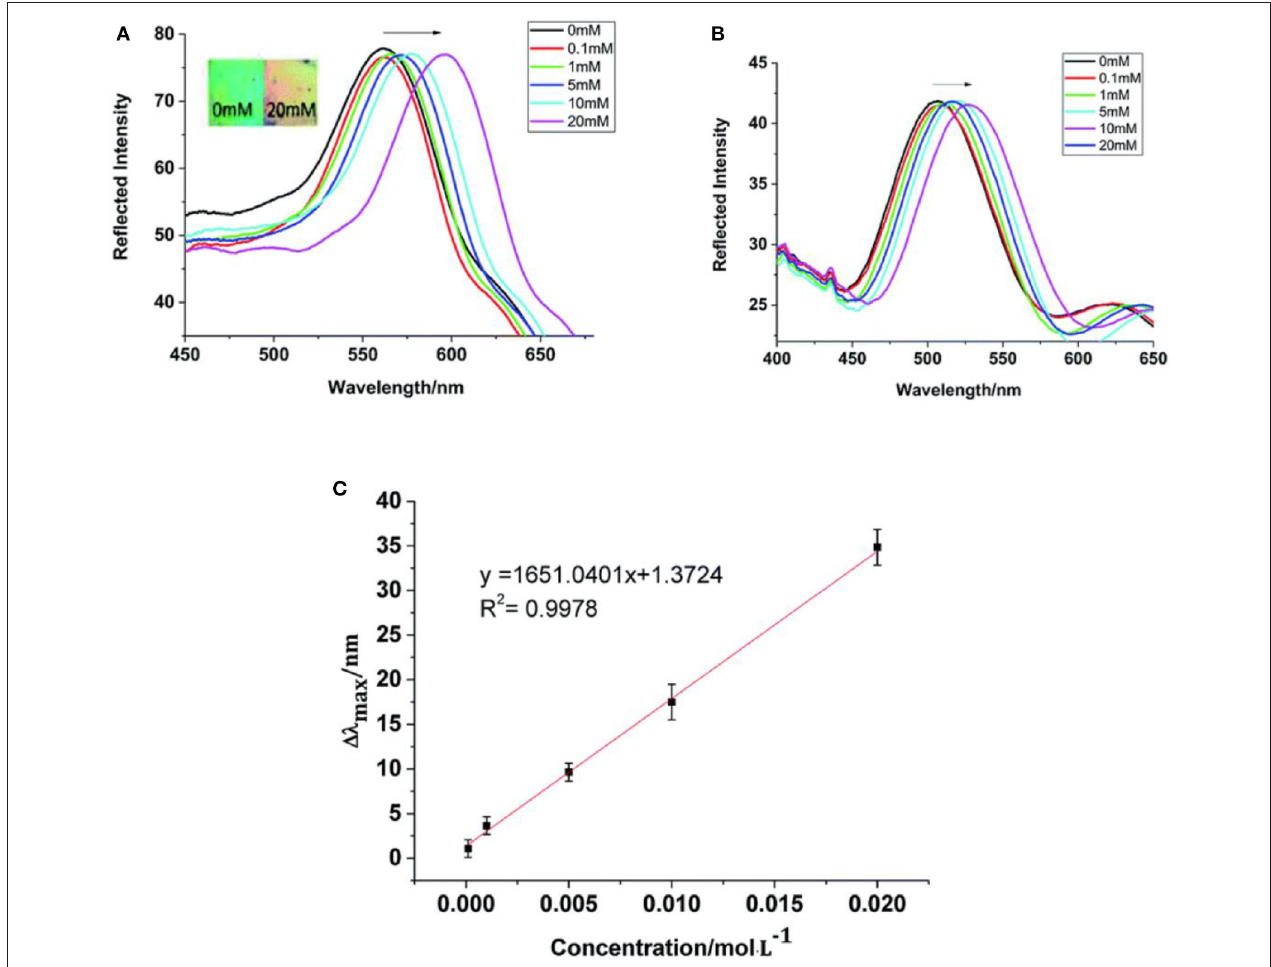
FIGURE 9 | Diffraction spectra of (A) molecularly imprinted photonic crystals (MIPC) and (B) NIPC samples, and (C) a quantitative curve of the MIPC response to benzocaine (reprinted with the permission of Chen S. et al., 2019; copyright 2019 Royal Society of Chemistry).